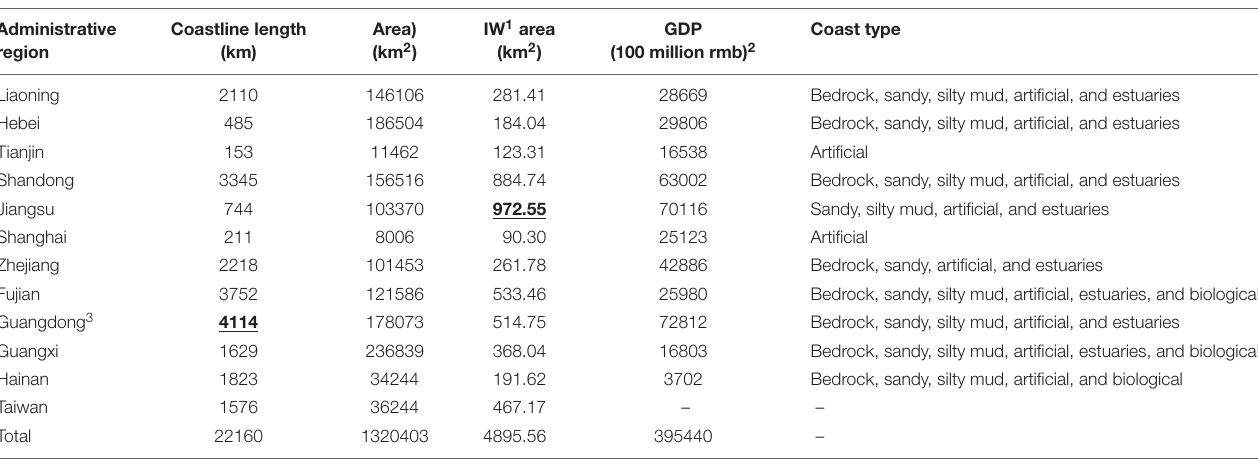
FIGURE 1 | The location of the Chinese intertidal zone (A) and its area distribution at 50-km resolution (B) . The location and distribution map are based on 2015 data. TABLE 1 | Intertidal wetland distribution and coast type among